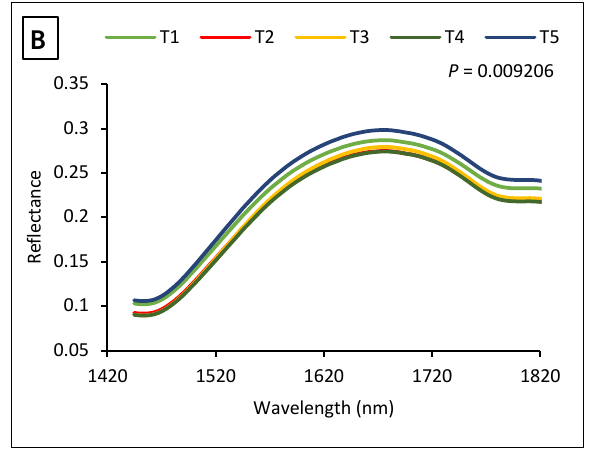
Figure 5. Region B Discriminating Treatment Levels